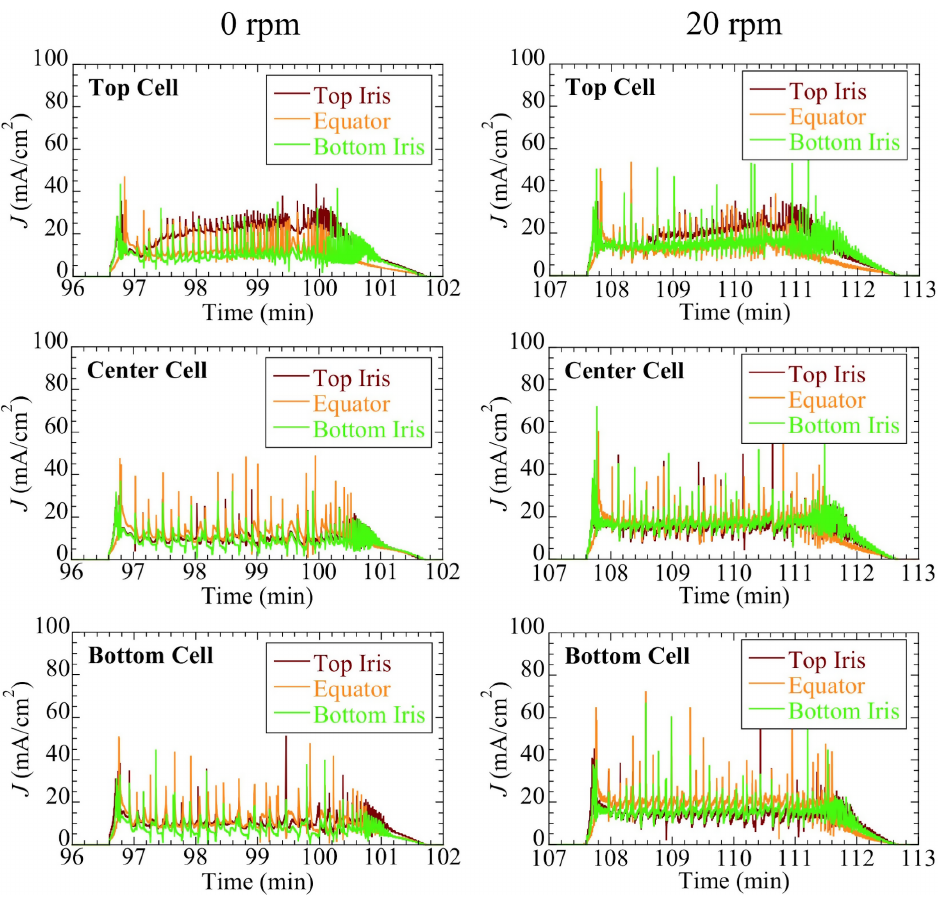
FIG. 12. Coupon currents in the top, center, and bottom cells at 0 (left) and 20 rpm (right). The acid flow was circulated at 5 L = min, and the cavity temperature was set at ∼ 15 °C in both